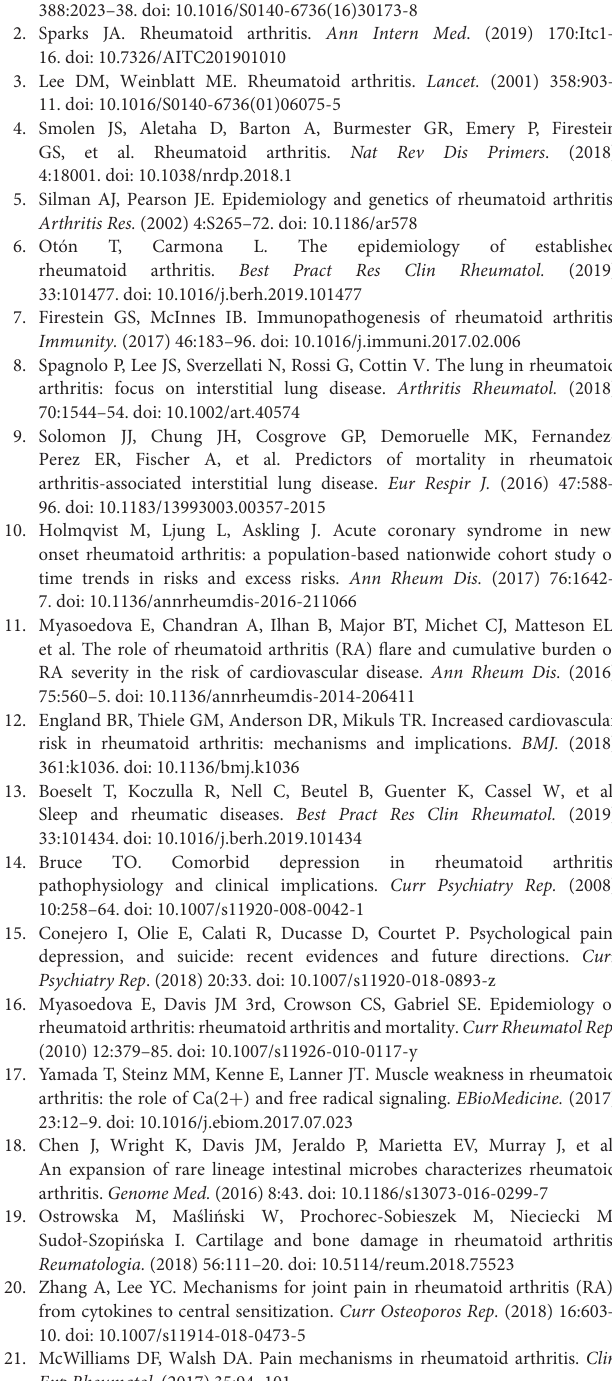
Supplementary Table 4 | The third-order association analysis between symptoms and high frequency used herbs (Confidence > 50, Support > 10, Lift > 1.2).